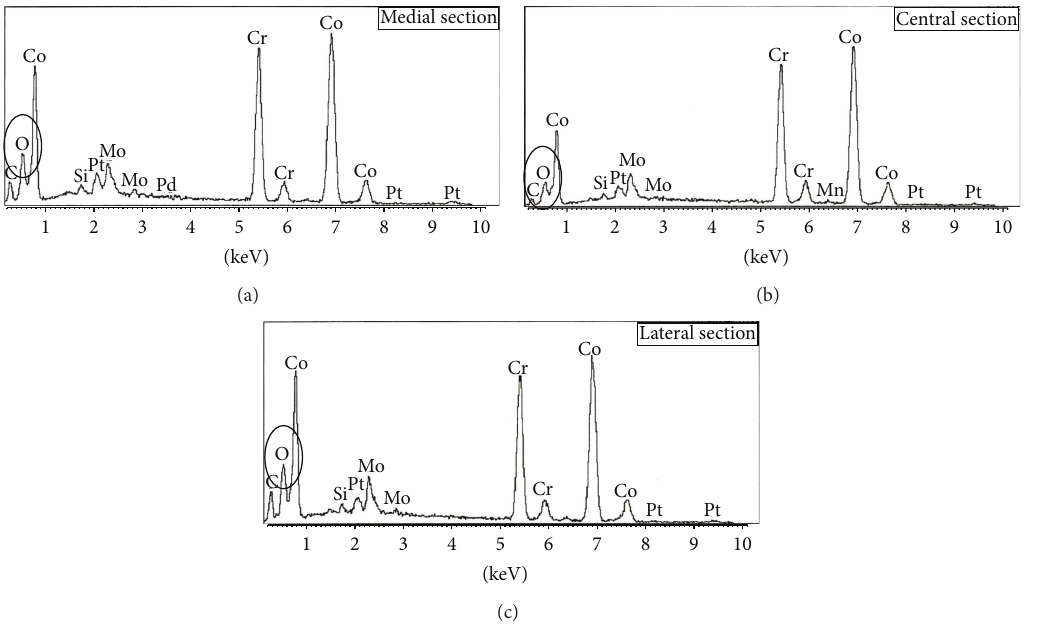
Figure 6: The results of scanning electron microscope- (SEM-) energy dispersive X-ray spectroscopy (SEM-EDX). (a), (b), and (c) showed the results of SEM-EDX at medial section, central section, and lateral section, respectively. Much higher oxygen at the medial and lateral sections was detected compared with the central